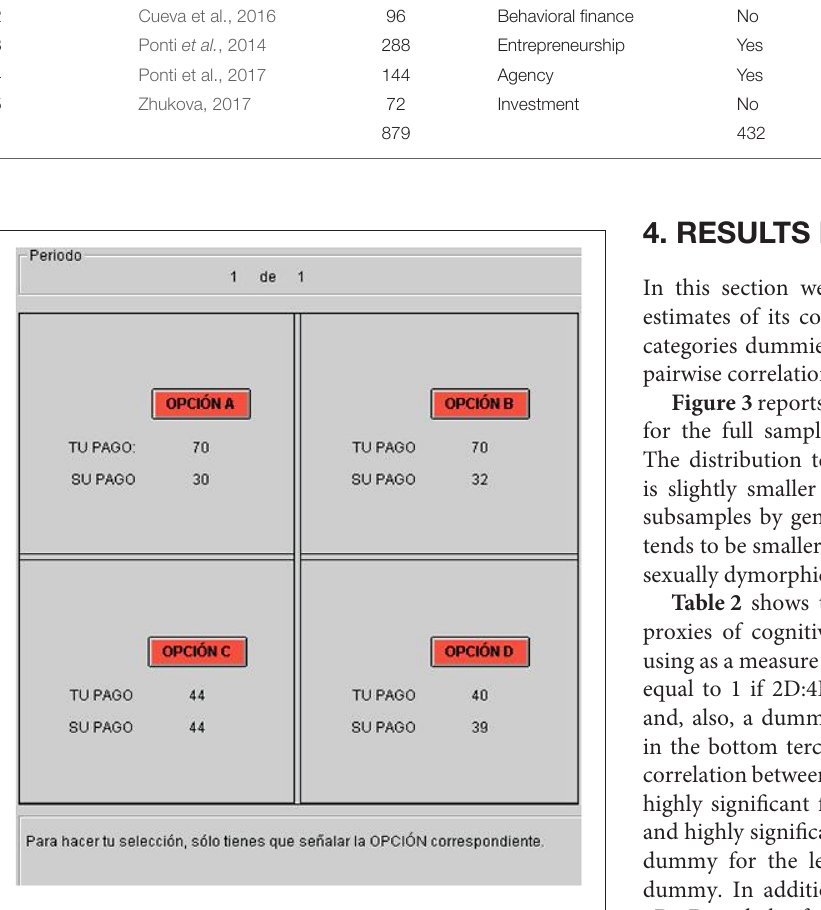
FIGURE 1 | User interface for distributional decisions in projects 3 and